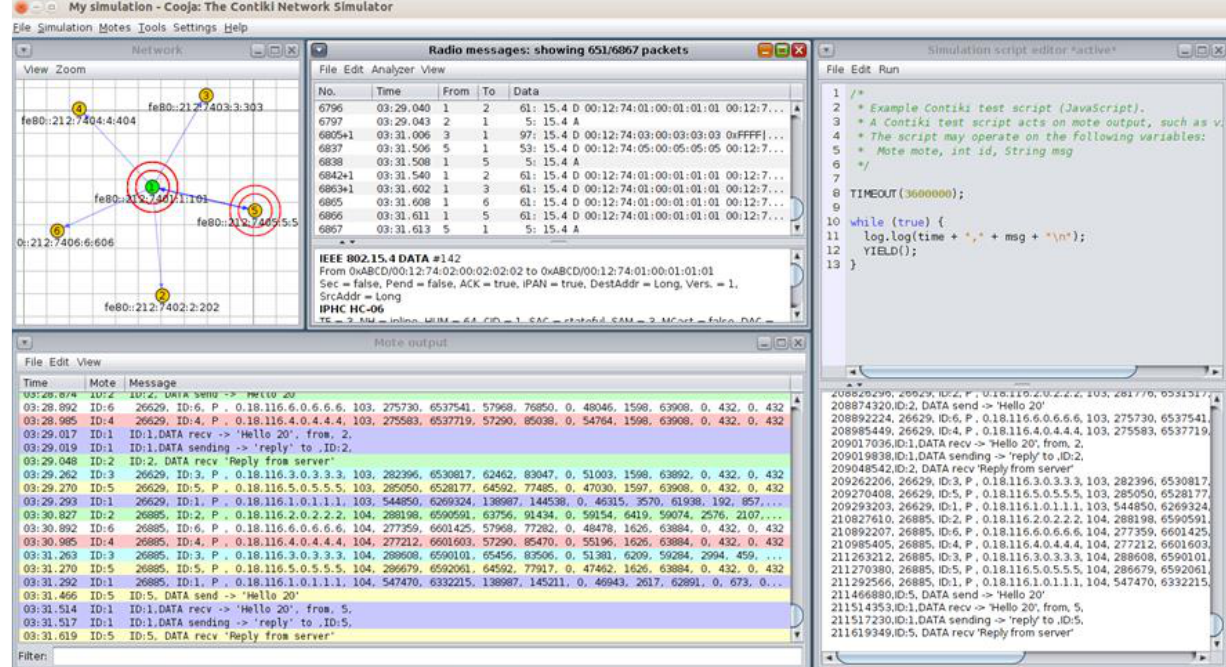
Figure 3. Cooja Simulator — motes’ outputs .